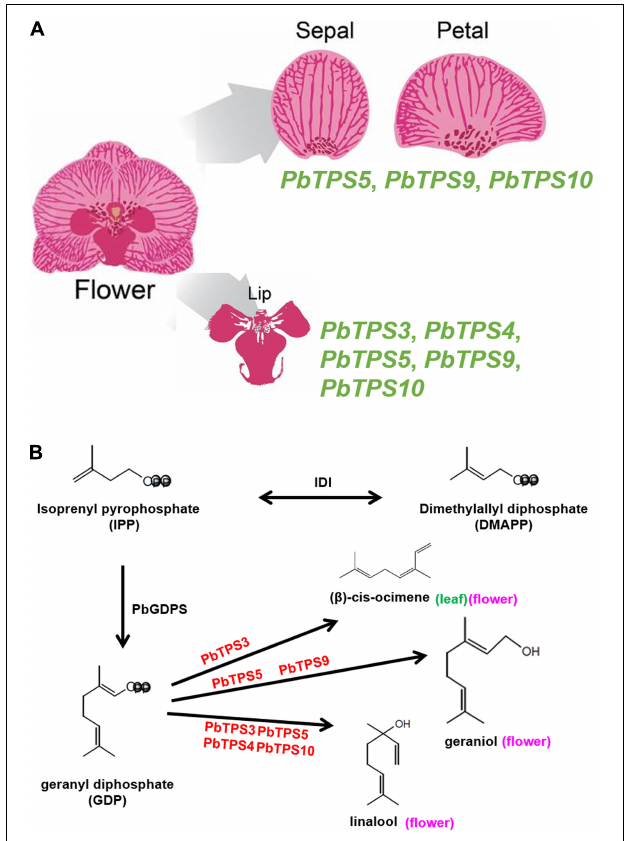
FIGURE 8 | (A) The biosynthesis pathway of linalool, geraniol, and ( β )- cis -ocimene in flower or ( β )- cis -ocimene in the leaf of P. bellina from GDP. More than one enzyme can use GDP as substrate for producing linalool ( PbTPS3 , PbTPS4 , PbTPS5 , and PbTPS10 ), geraniol ( PbTPS5 and PbTPS9 ), or ( β )- cis -ocimene ( PbTPS3 ). In addition, one enzyme may produce more than one product using GDP as the substrate, such as PbTPS3 for both linalool and ( β )- cis -ocimene biosynthesis. (B) Various PbTPS genes involved in monoterpene biosynthesis in a single